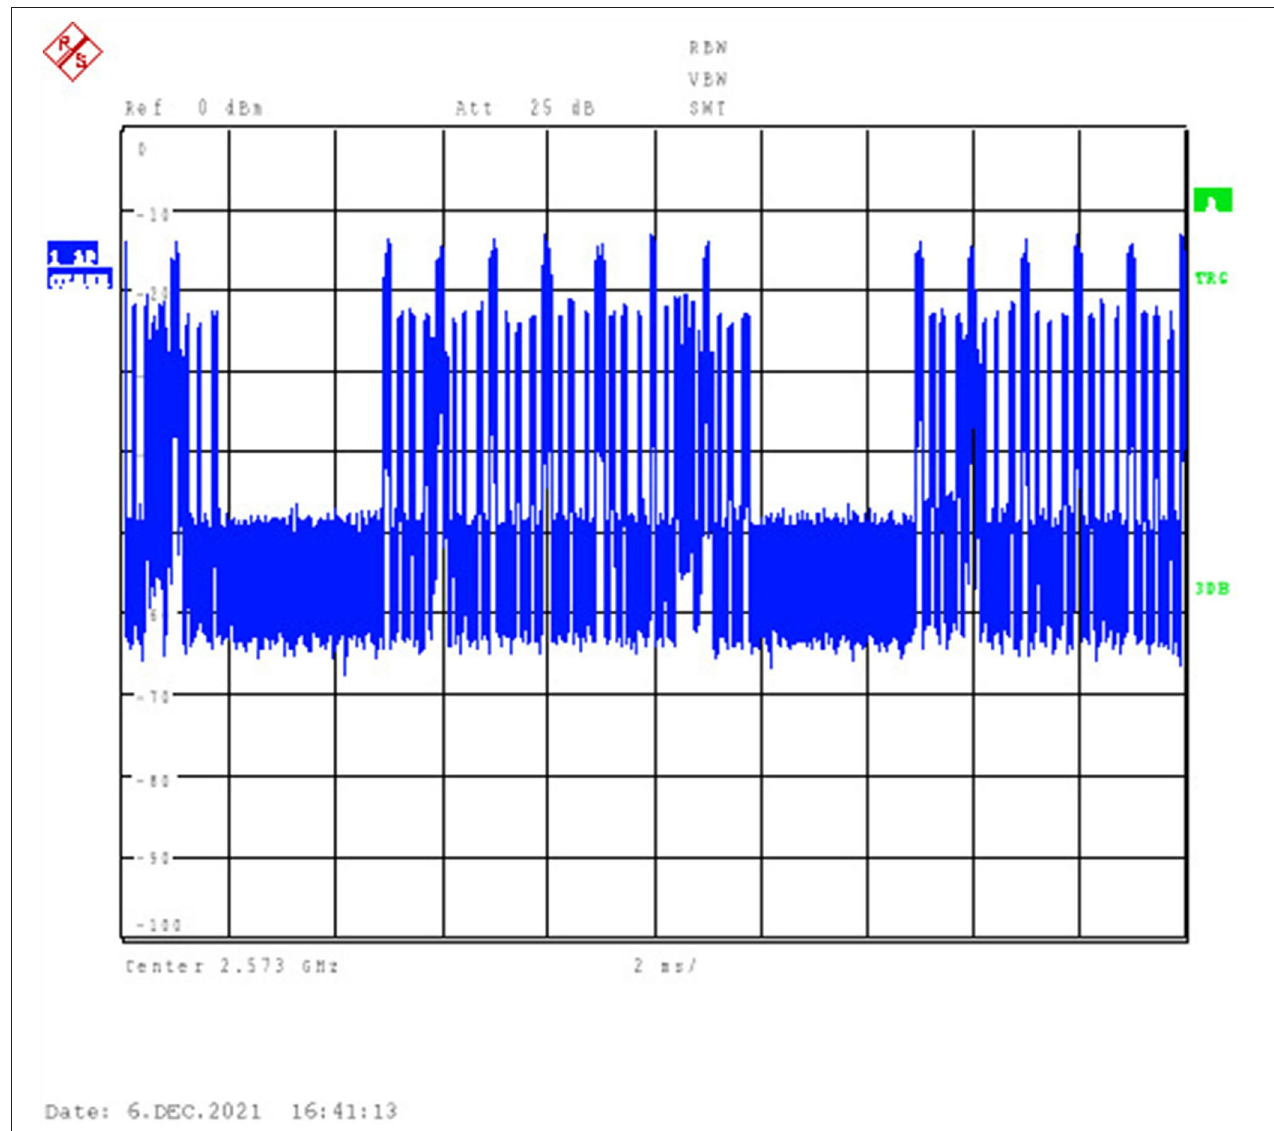
FIGURE 2 | Time-domain signal generated by CMW 500 and visualized by Rohde and Schwarz FSU26 Spectrum